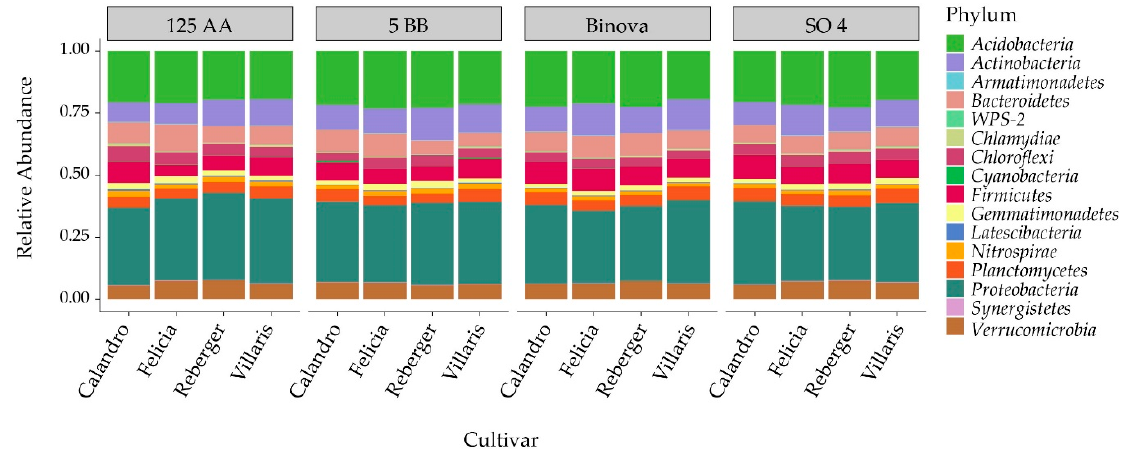
Figure 3. Taxonomic composition of rhizosphere bacterial communities per rootstock and cultivar. Bars show the relative abundance of bacterial taxa merged at the phylum level. Phyla whose abundance was <20 were not shown for clarity of data